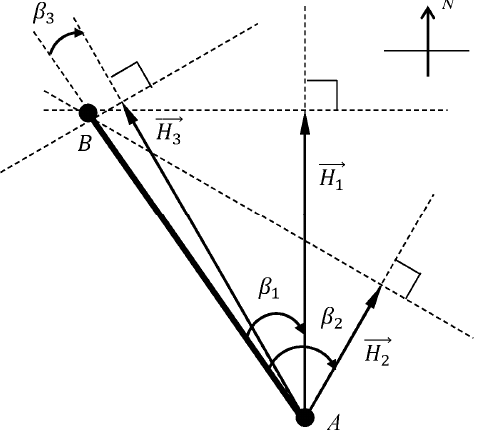
Figure 17. True wave height retrieval with three measured wave heights. The angles to wave: 𝛽 (cid:2869) = 40 degrees, 𝛽 (cid:2870) = 70 degrees, and 𝛽 (cid:2871) = 10 degrees.